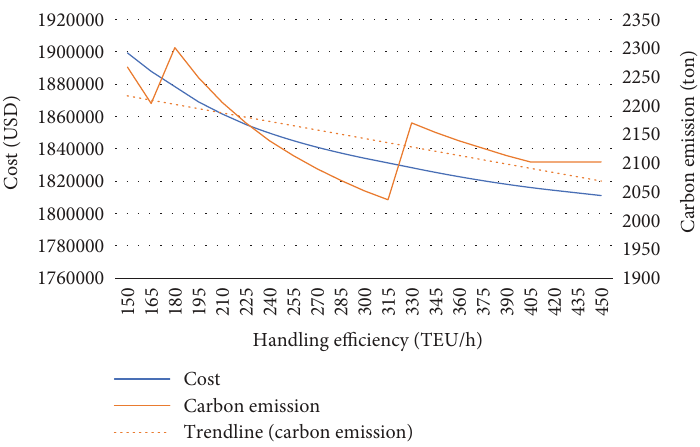
Figure 7: Computation results for loading and unloading e ffi ciency